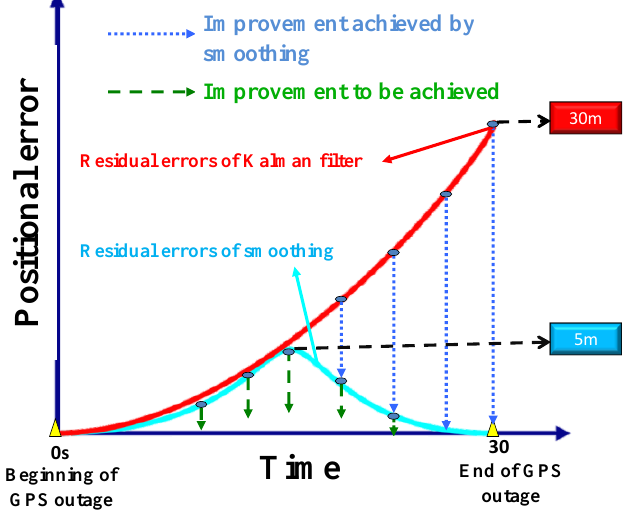
Figure 2. The impact of KF’s limiting factors on positional error during GPS signal